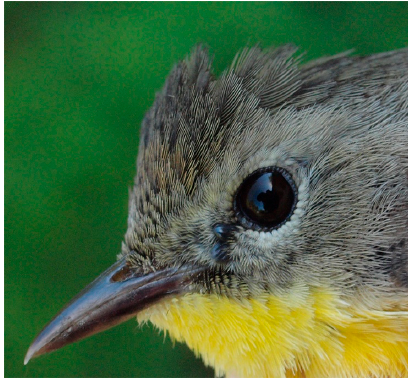
Figure 2. Common Yellowthroat parasitized by two engorging I. scapularis nymphs, both together, anterior to left eye. One of the two nymphs was positive for B. burgdorferi sensu lato. Photo credit: Simon Duval.